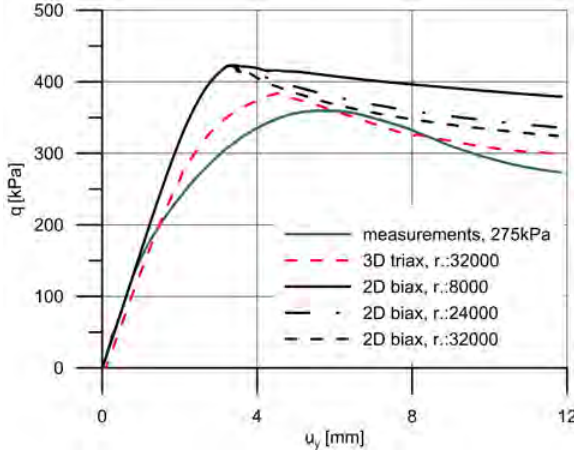
Figure 4. Triaxial stress strain curves – softening.